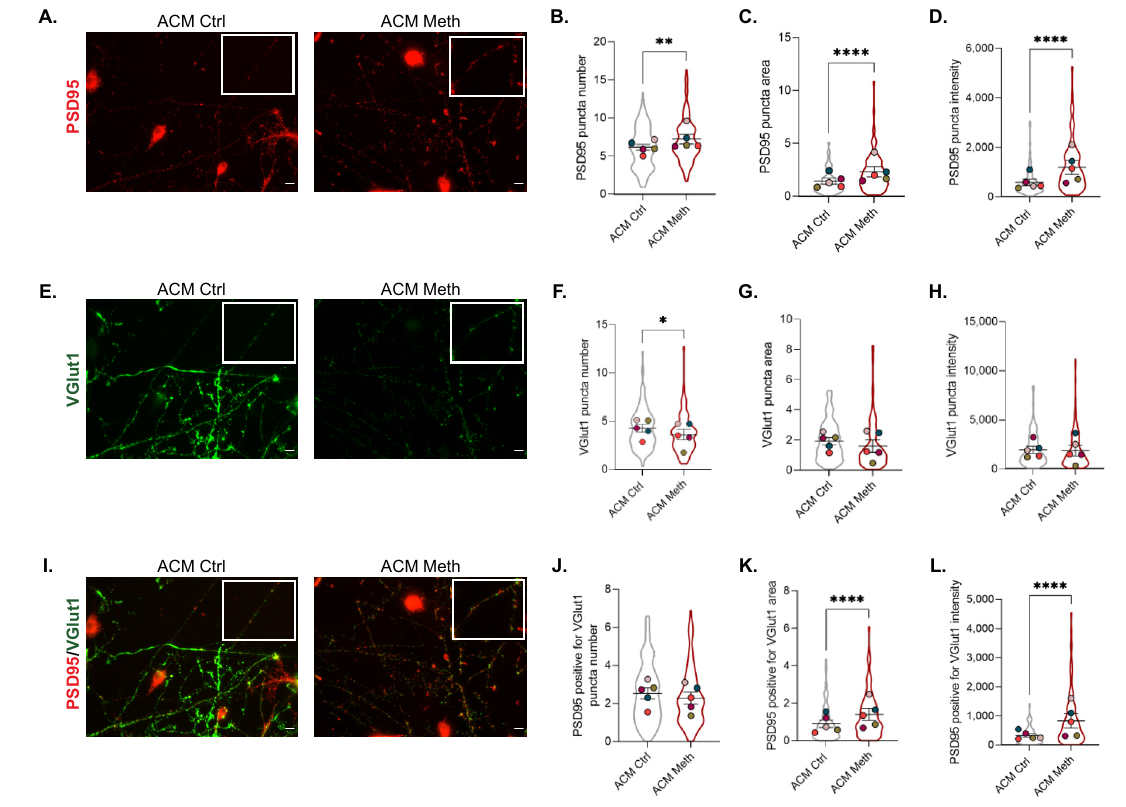
Figure 5. Synaptic plasticity was concomitantly increased. ( A ) Fluorescence imaging of microglial cells co-cultured with neurons and exposed to ACM Ctrl or ACM Meth for 24 h. Cells were immunolabeled for PSD95 (red), and results represent the PSD95 puncta ( B ) number, ( C ) area, and ( D ) intensity. ( E ) Fluorescence imaging of microglial cells co-cultured with neurons and exposed to ACM Ctrl or ACM Meth for 24 h. Microglial cells were immunolabeled for vGlut1 (green), and results represent the Vglut1 puncta ( F ) number, ( G ) area, and ( H ) intensity. ( I ) Fluorescence imaging of microglial cells co-cultured with neurons and exposed to ACM Ctrl or ACM Meth for 24 h. Cells were immunolabeled for PSD95 (red) and VGlut1 (green), and results represent the ( J ) PSD95 plus vGlut1-positive puncta number, ( K ) puncta area, and ( L ) puncta intensity. Symbol colors of each graph represent the mean of each independent cell culture ( n = 5) and the violin plots the variability of all neuronal segments quantified (ACM Ctrl—149; ACM Meth—111 segments). Statistical analysis was performed using a linear mixed model followed by Tukey–Kramer comparison test. Scale bar: 10 μ m. * p < 0.05, ** p < 0.01, and **** p < 0.0001.